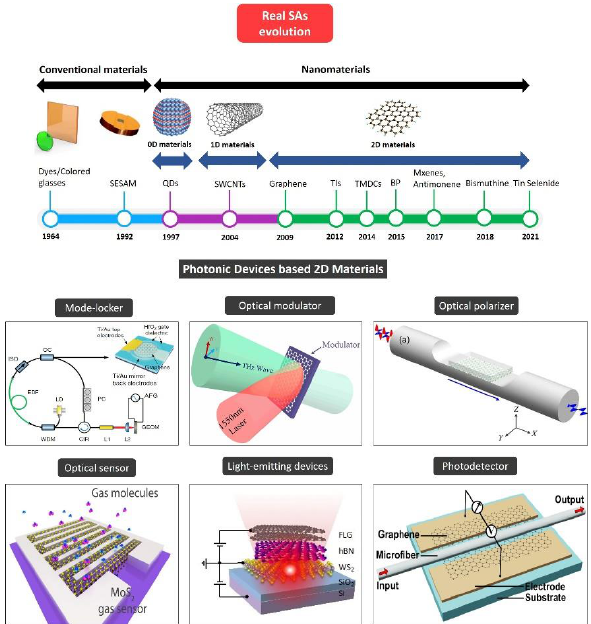
Figure 1. The evolution of real saturable absorber technologies and their applications as photonic devices. Reprinted with permission from ref. [24]. Copyright 2018 John Wiley and Sons.